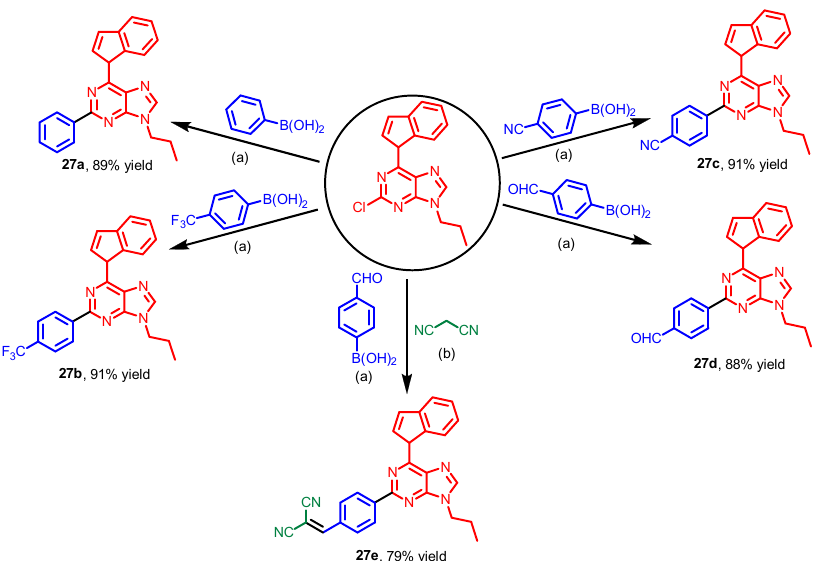
Scheme 22. Synthesis of 27a – e . Reagents and conditions: ( a ) Pd(PPh 3 ) 4 , K 2 CO 3 , 2,6-dioxane, H 2 O, 80 ◦ C, 8 h. ( b ) Malononitrile, piperidine, DMF, rt, 2 h.